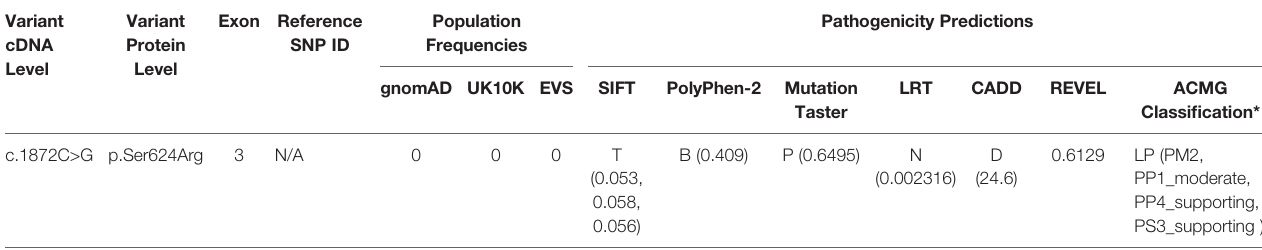
TABLE 1 | Characteristics of the NLRP3 variant detected in this study. Variant